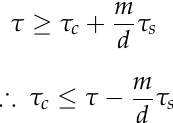
Figure 6. The range intersection of acceptable bounded-error data.